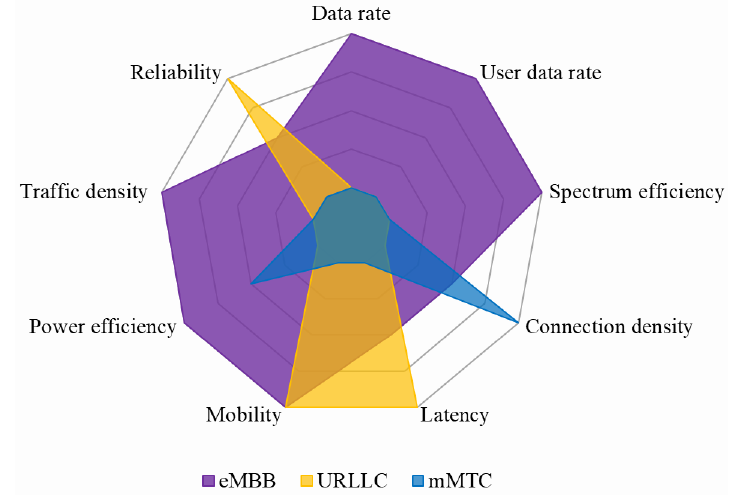
Figure 2. Service categories and quality requirements in 5G networks.